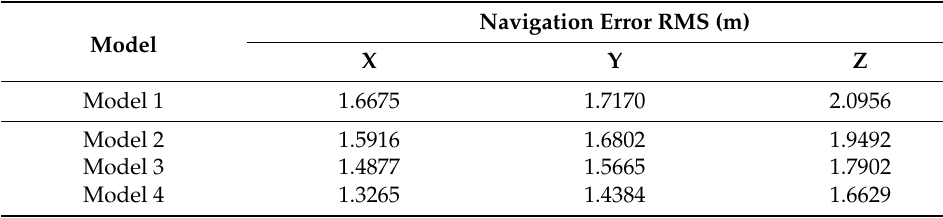
Table 5. The navigation error RMS of the three models.